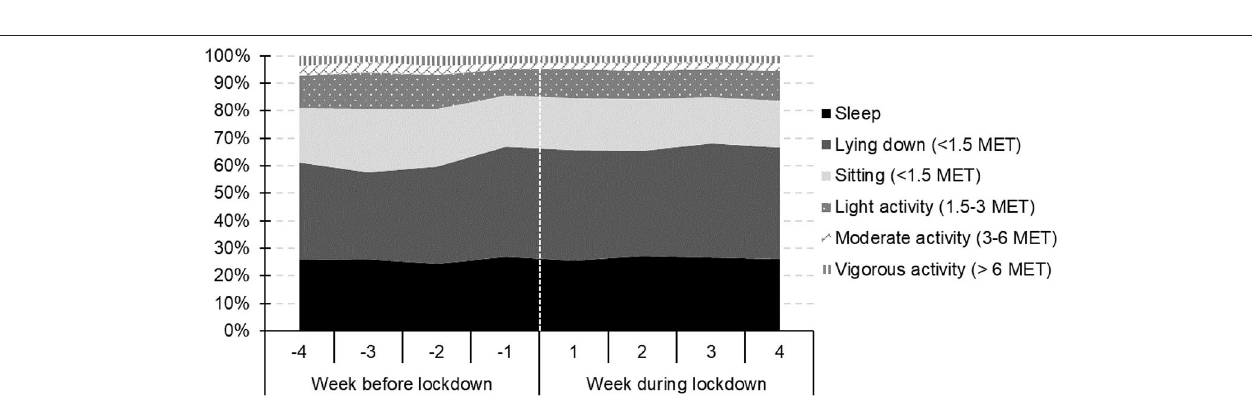
FIGURE 1 | The proportions of the total training time each week spent in the different intensity zones during the 4-week periods prior to and at the beginning of the lockdown.